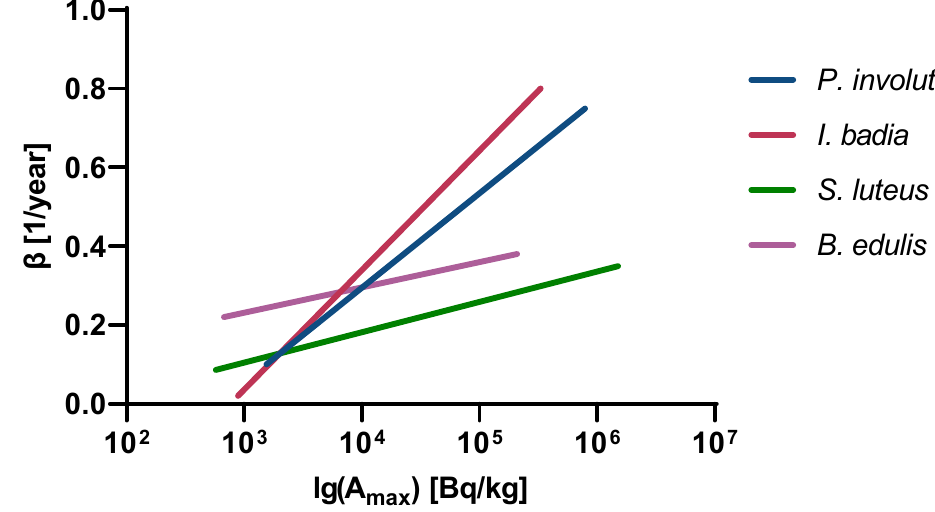
Figure 2. Dependence of the rate of 137 Cs concentrations decrease (β), on the logarithm of the 137 Cs specific activity (A max ) in specific activity (A max ) in fungi.